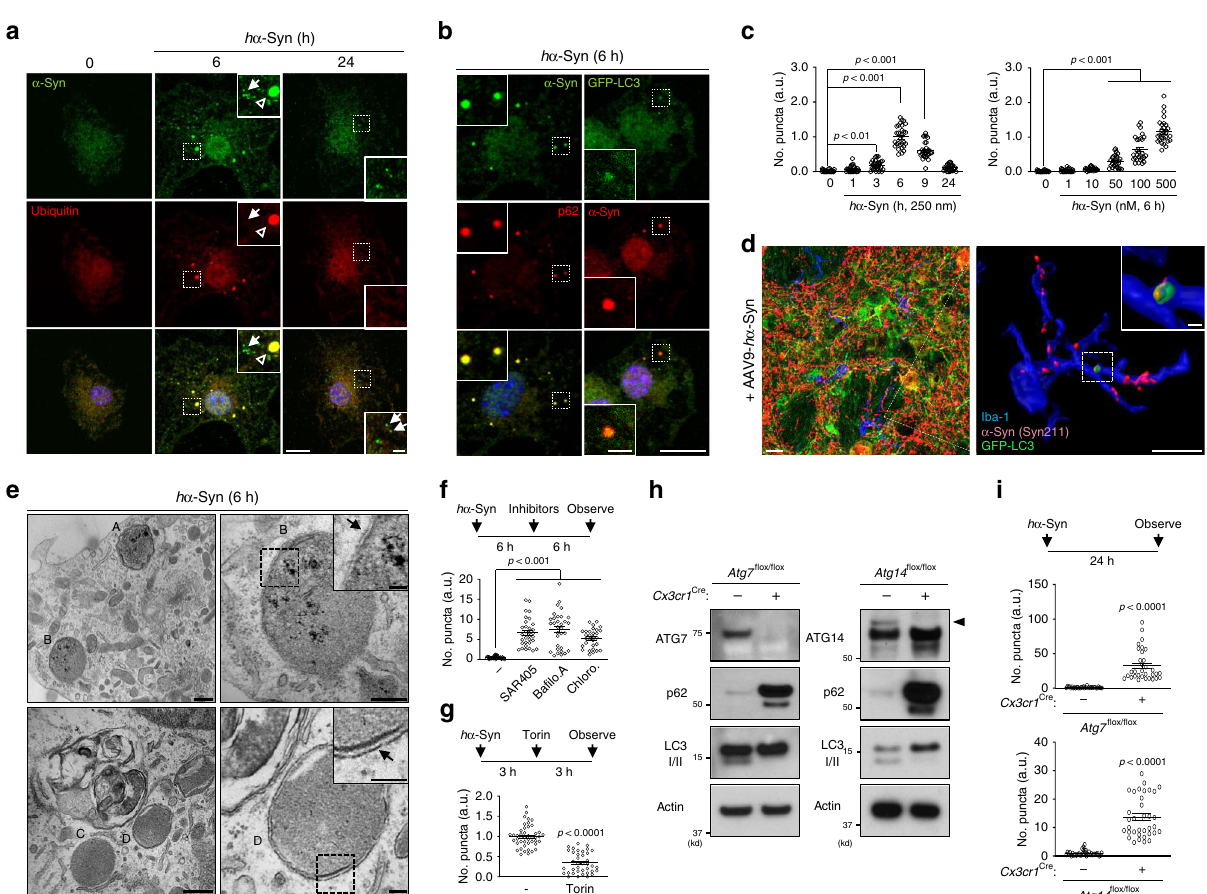
Fig. 2 Microglia-engulfed α -synuclein is degraded by autophagy. a , b , c Cultured primary microglia from WT mice ( a and left panels of b ) and GFP – LC3- transgenic mice (right panels of b ) were treated 250 nM h α -Syn protein and stained with antibodies against human α -synuclein (MJFR1 clone, a and b ), ubiquitin ( a ), or p62 ( b ). The number of h α -Syn/ubiquitin-positive puncta was quanti fi ed ( c , n = 29, three independent experiments). In a , empty arrowheads indicate a portion of α -synuclein colocalized with ubiquitin-positive puncta and disappear in 24 h. Arrows represent a portion of α -synuclein not colocalized with ubiquitin. p -values were calculated by one-way ANOVA with Newman – Keuls post hoc test. F(5,168) = 139.6, p = 6.43E-58, left panel; F(5,162) = 118.4, p = 3.14E-52. Scale bar, 10 µ m; 2 µ m in magni fi ed boxes. d At 6 weeks post AAV- h α -Syn inoculation into GFP – LC3 mice, brain slices were fi xed and stained with antibodies against human α -synuclein, GFP, and Iba-1 (left panel). 3D surface-rendering images of each protein in microglia were made with Imaris software (Bitplane, right panel). Scale bar, 10 µ m; 1 µ m in the magni fi ed box. e Ultrastructure of puncta from 250 nM h α -Syn protein- treated cells for 6 h was observed by an electron microscope. Arrows indicate double-membrane structures. Scale bar, 500 nm in the left panel; 100 nm in the right panel. f , g Microglia were treated with 250 nM h α -Syn protein and SAR405 ( f , n = 32), Ba fi lomycin A1 ( f , n = 32), and Chloroquine ( f , n = 30) or Torin ( g , n = 38) was added. The number of h α -Syn/ubiquitin-positive puncta was quanti fi ed in the lower panel. p -values were calculated by one-way ANOVA with Newman – Keuls post hoc test ( f , F(3,130) = 39.88, p = 2.43E-18) and unpaired two-tailed Student ’ s t test ( g , p = 5.38E-18). h , i Microglia cultured either from Atg7 fl ox/ fl ox mice (left panel) from Atg14 fl ox/ fl ox mice (right panel) with or without Cx3cr1 Cre expression were assayed for W.B using antibodies against ATG7 or ATG14, p62, and LC3 I/II ( h ). Cells were treated with 250 nM h α -Syn protein for 24 h, and the number of h α -Syn/ubiquitin- positive puncta was quanti fi ed ( I , n = 32, p < 0.0001 for Atg7; n = 35, p < 0.0001 for Atg14). p- values were calculated by two-tailed Mann – Whitney U test. All values are reported as mean ± SEM. Data are representative of at least three independent